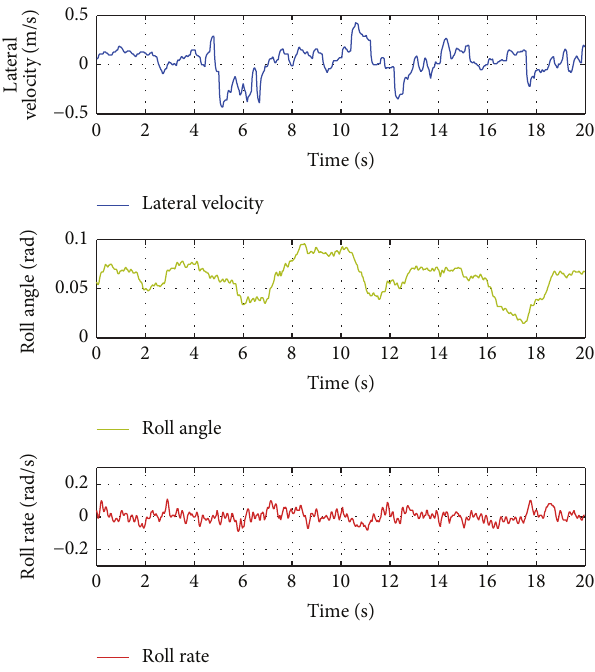
Figure 9: The lateral output of actual